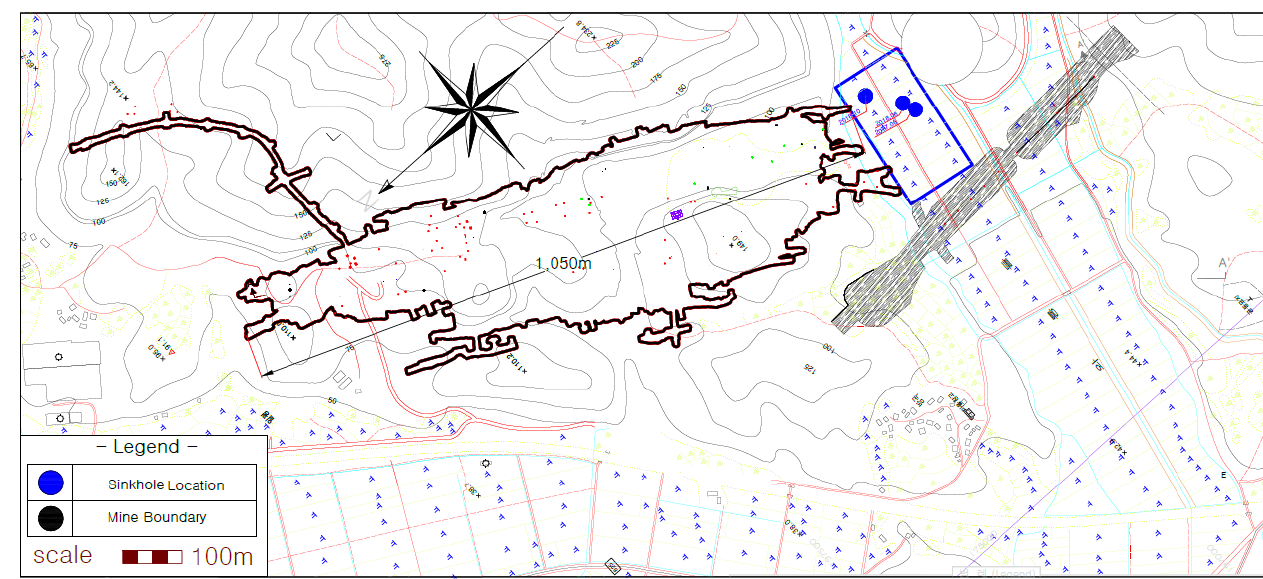
Figure 4. Gun-dong mine layout and adjacent area of sinkholes.